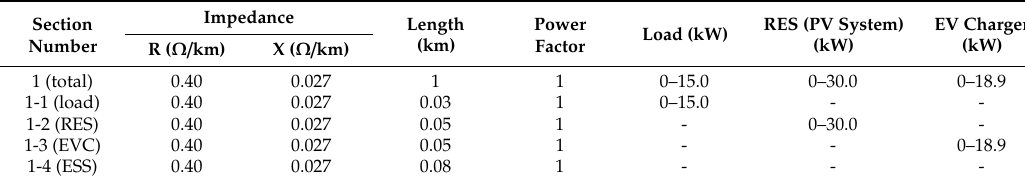
Table 3. Simulation data.